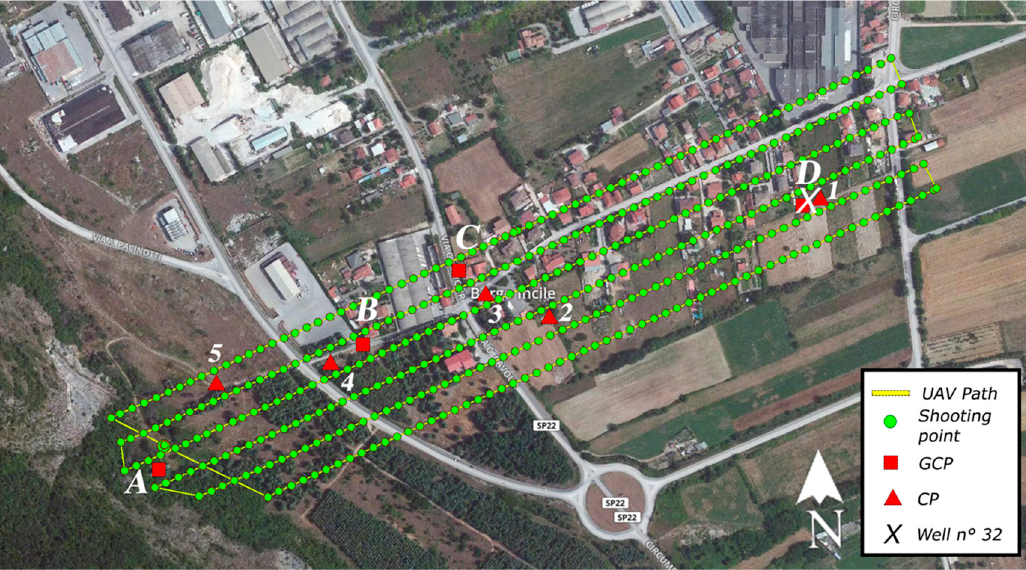
Figure 10. Flight plan used for photographic acquisitions in Borgo Incile di Avezzano (AQ). Table 2. Flight parameters.